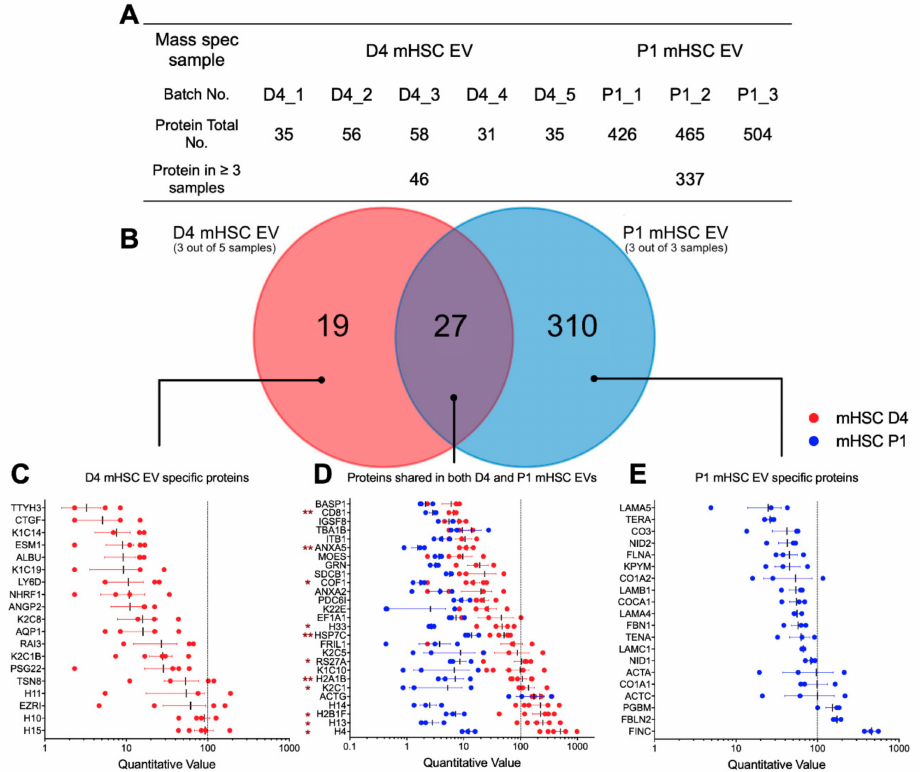
Figure 3. Proteomic composition of mHSC EVs. ( A ) Summary of quantitative features of EV proteins analyzed from five D4 mHSC EV samples or three P1 mHSC EV samples. ( B ) Venn diagram showing distribution of proteins between EVs from D4 versus P1 mHSC. The figure also shows the identities and quantifications of ( C ) the 19 proteins specific for D4 mHSC EVs; ( D ) the 27 proteins shared by both groups for which 11 proteins were significantly enriched in EVs from D4 mHSC (*, p < 0.05, **, p < 0.01) and ( E ) the 20 most abundant proteins specific for EVs from P1